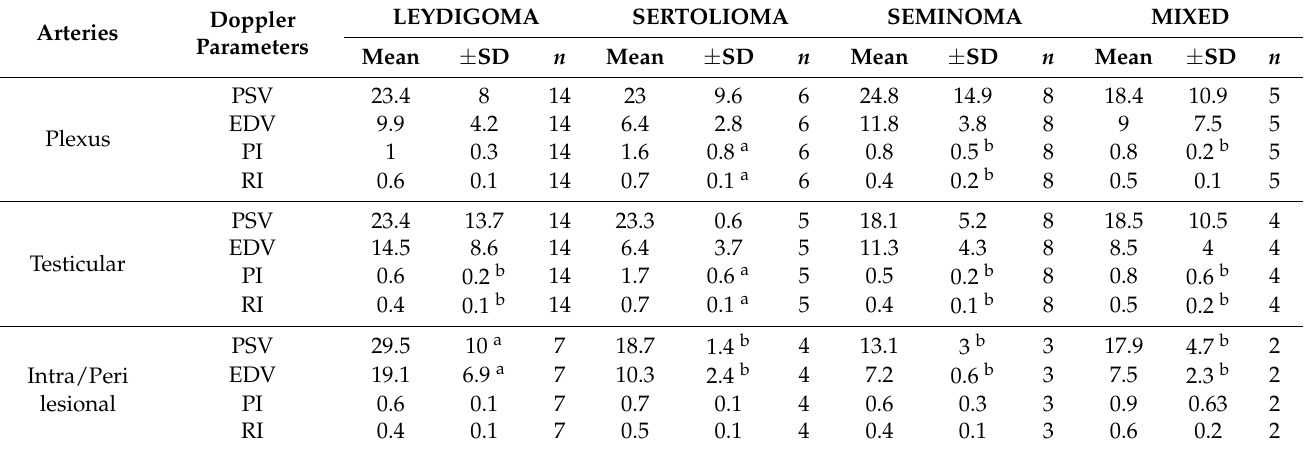
Table 3. Pulsed-wave Doppler parameters derived from three different regions drawn within pampini- form plexus, marginal, and intra-testicular arteries of pathological testicles with different tumor lesions ( n = 33) included in the comparative analysis. Peak systolic velocity = PSV, End diastolic velocity = EDV, Resistance index = RI, Pulsatility index = PI. Values are means ±